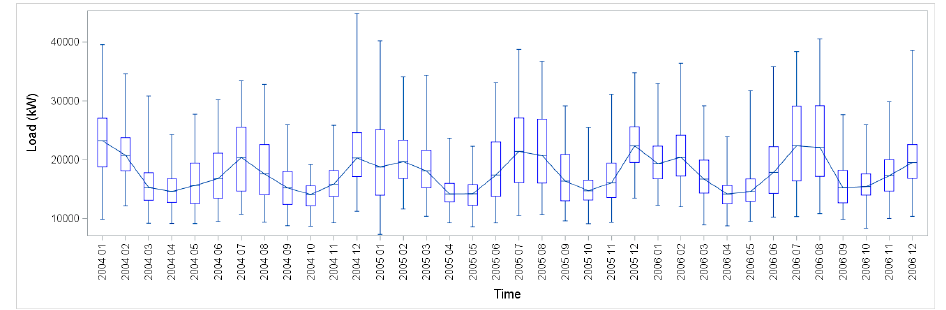
Figure 3. Boxplots of data grouped by month, for temperature ( up ) from station 6 and load ( down ) from zone 1.